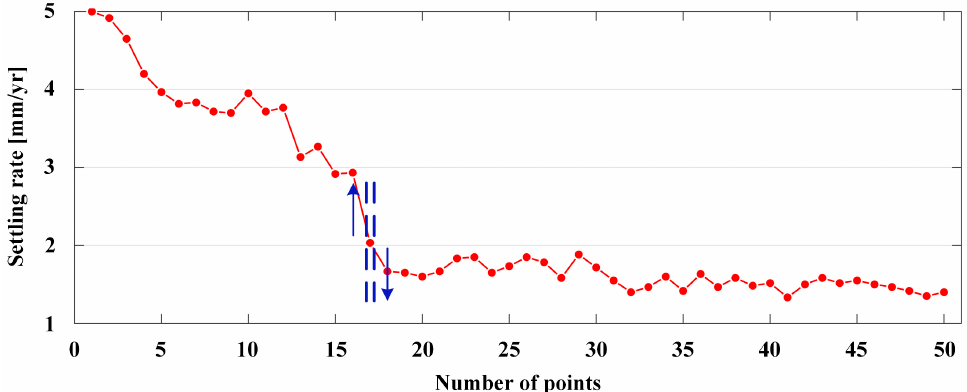
(cid:48) in Figure